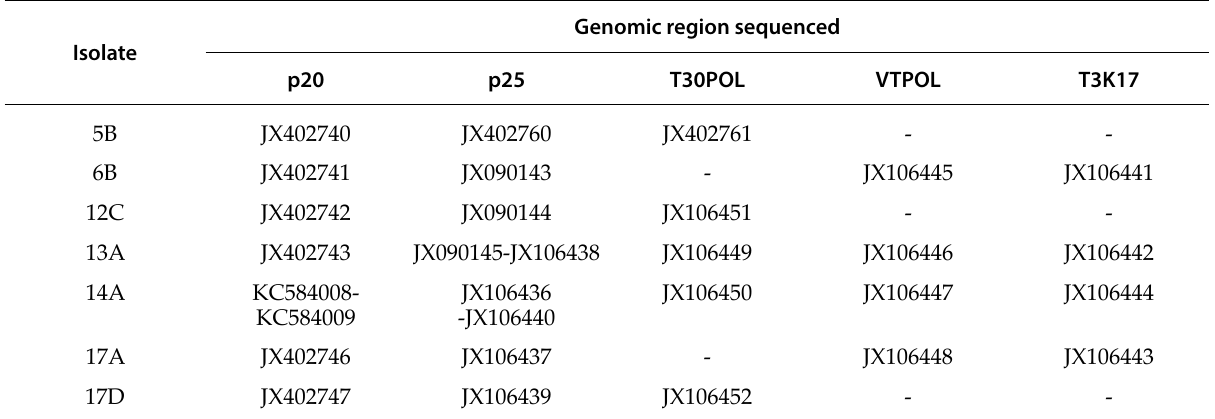
Table 3. GenBank accession numbers for the nucleotide sequences determined for the selected Citrus tristeza virus isolates from Calabria.